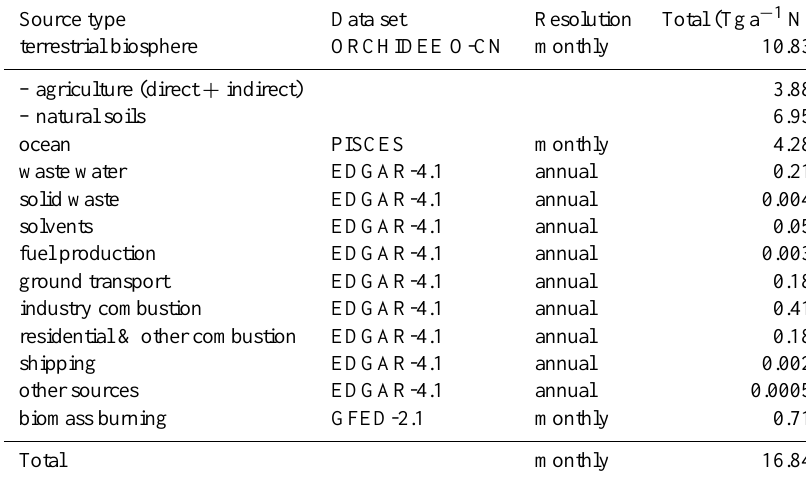
Table 3. N 2 O sources used in the a priori fluxes (totals shown for 2005).